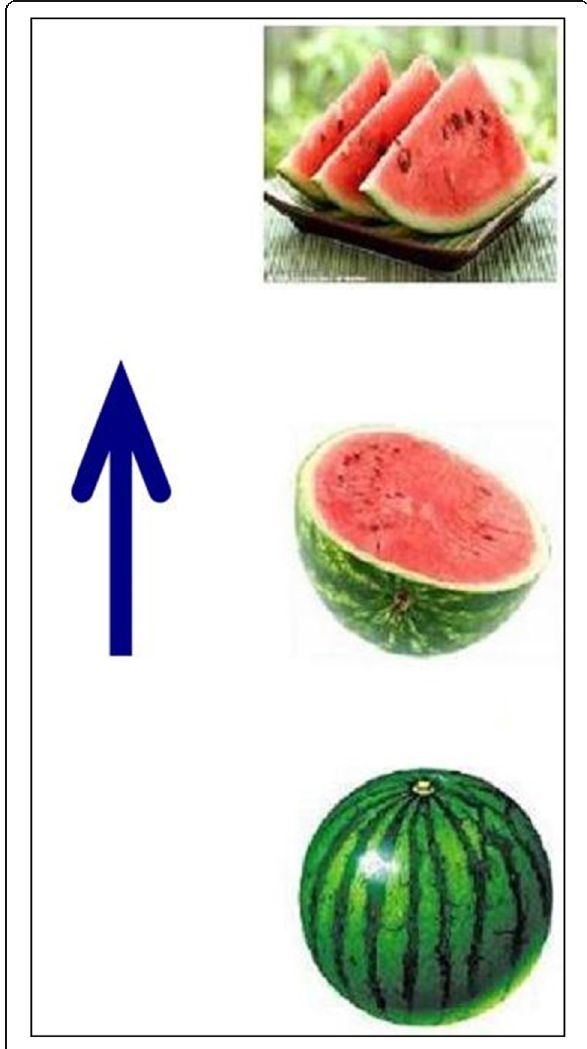
Fig. 7 An example of a vertical space-time incompatible target. This is an instance of a true